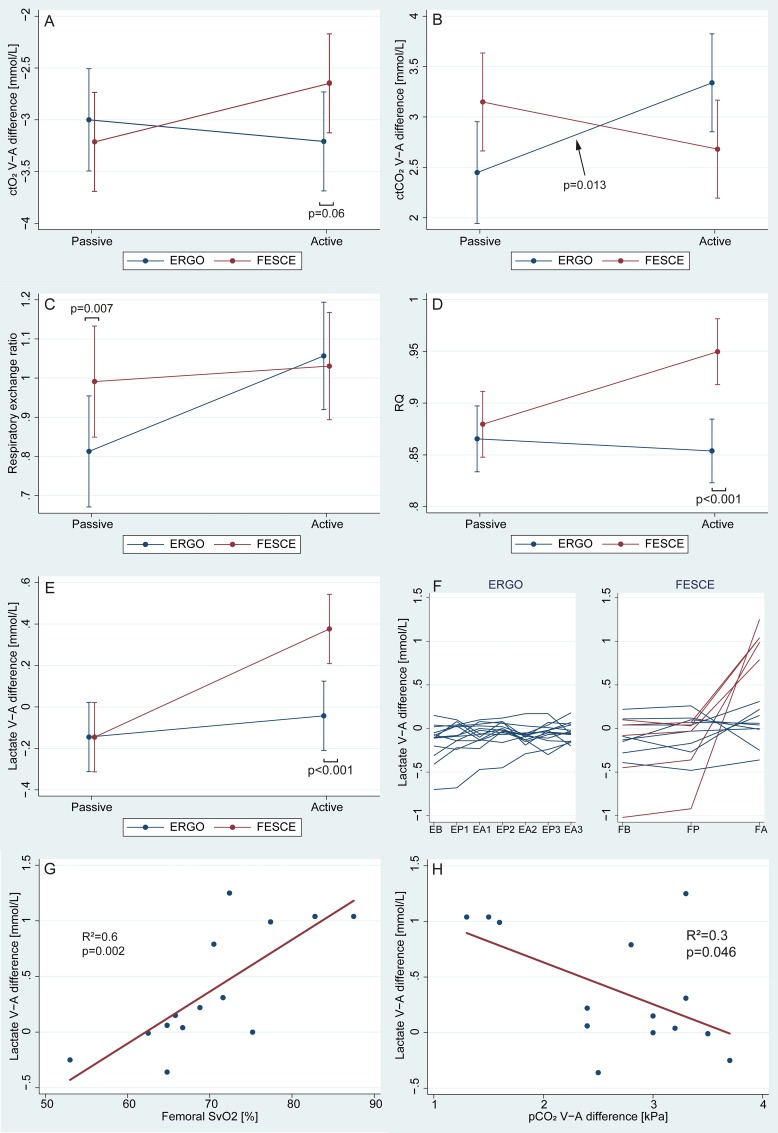
Venous-arterial (VA) differences studies.Lactate VA difference is derived from multiplying femoral VA differences of concentrations and calculated leg blood flow. See text for further details. Linear regression was used in G and H. Note: ctO2 and ctCO2 = total blood content of oxygen and carbon dioxide; RQ = whole body respiratory quotient; SvO2 = femoral venous saturation of haemoglobin with oxygen. ERGO = volitional cycling; FESCE = functional electrical stimulation-assisted cycling; Passive period vs Active FES/50W volitional period.